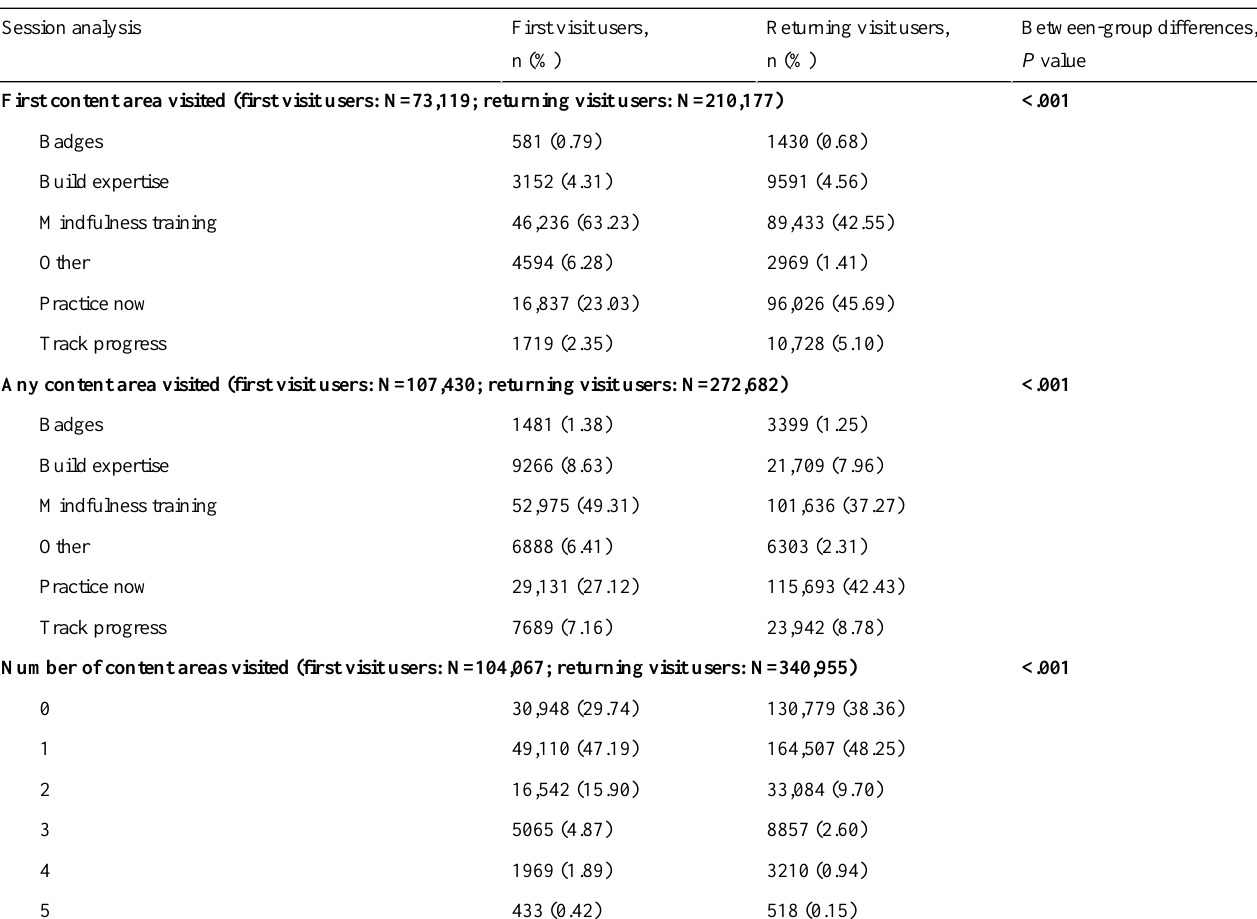
Table 3. Detailed session analysis for Mindfulness Coach by first-time users and returning users, from August 2018 to April 2019. (%)Session